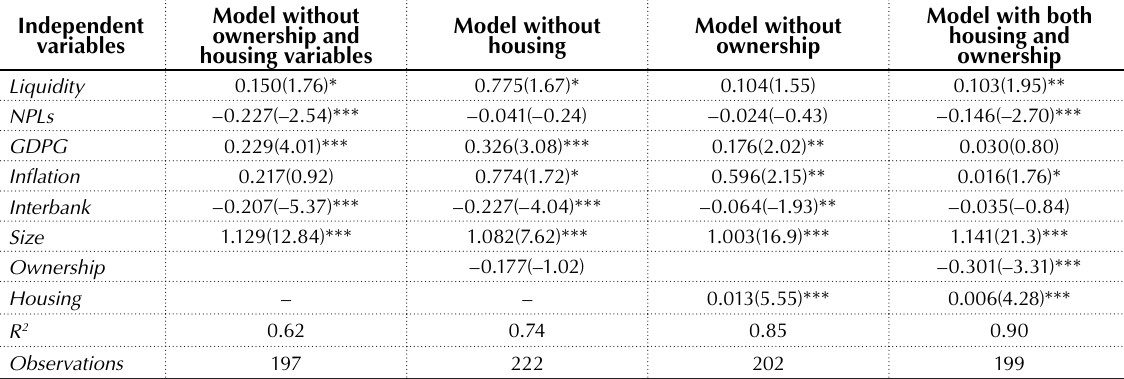
Table 4. The dependent variable is all commercial bank loans but with interbank rate Independent